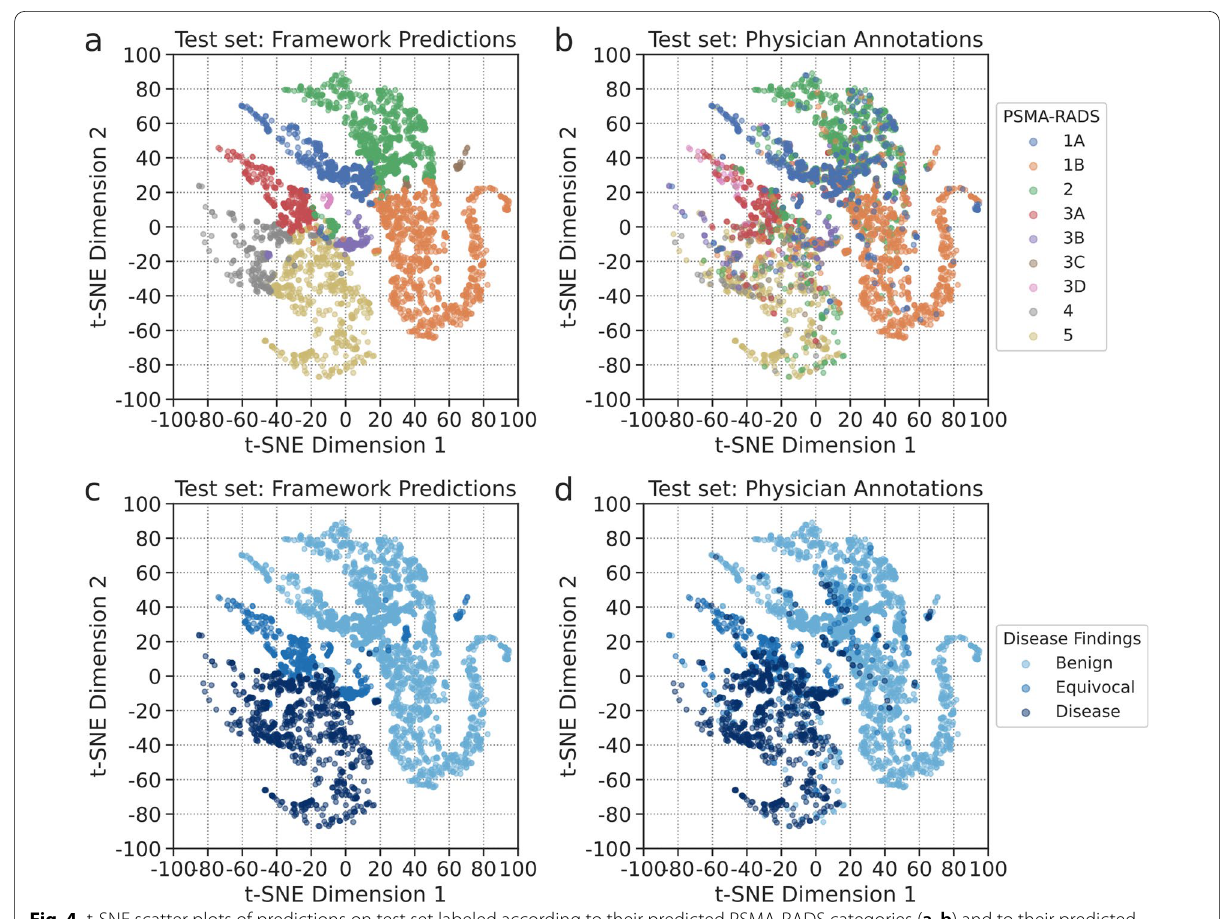
Fig. 4 t-SNE scatter plots of predictions on test set labeled according to their predicted PSMA-RADS categories ( a , b ) and to their predicted PSMA-RADS categories corresponding to benign, equivocal, and disease findings ( c , d